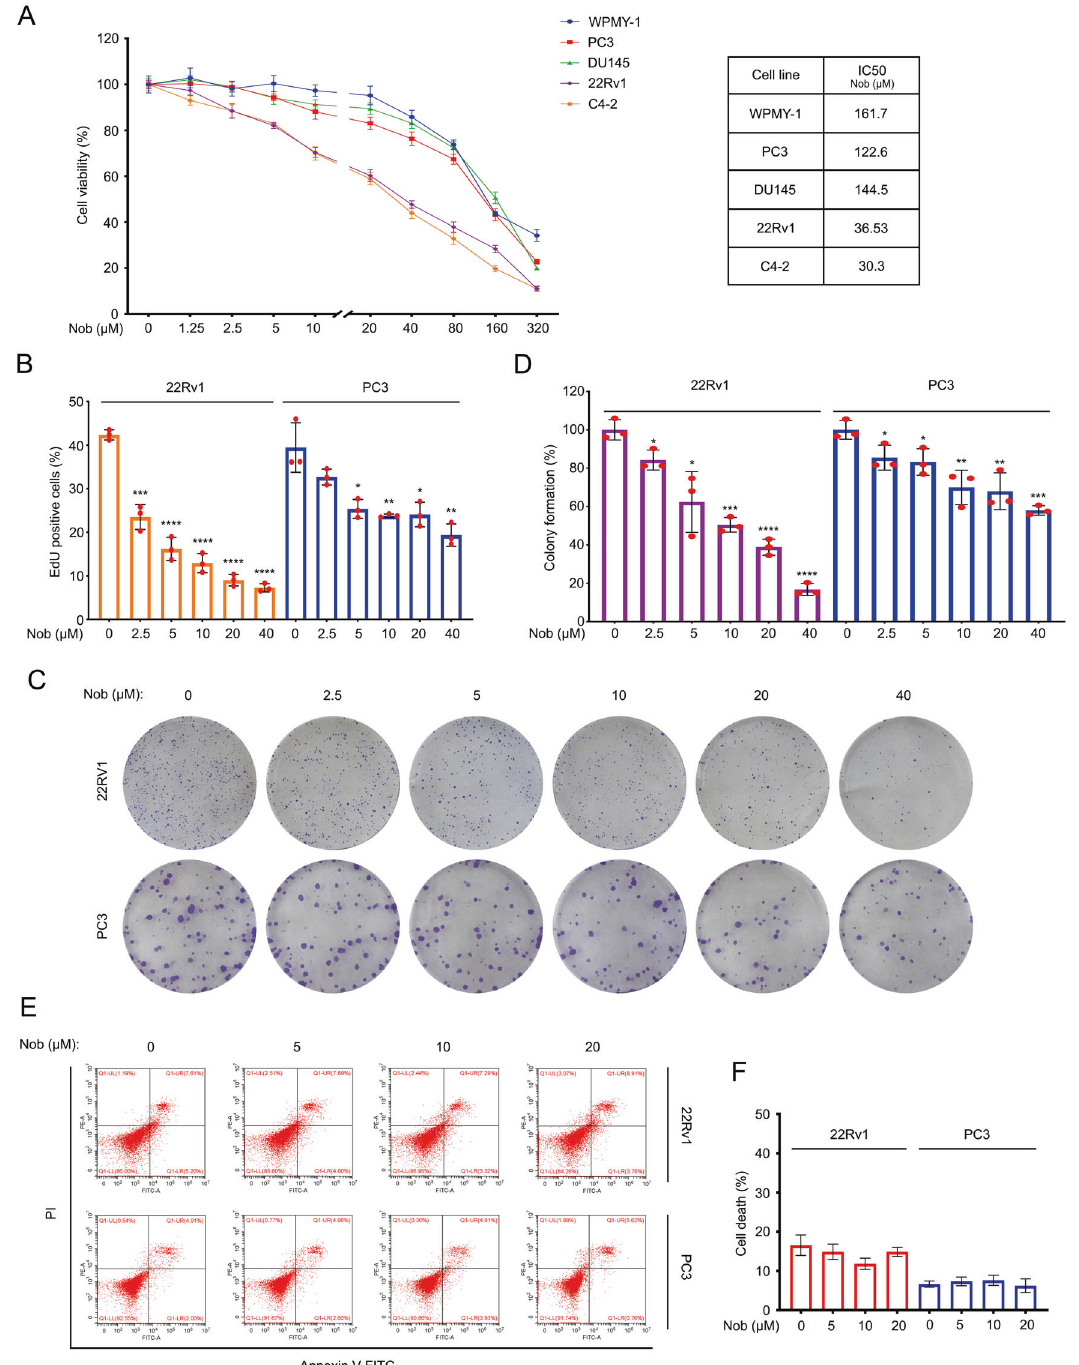
Fig. 1 Nobiletin more dramatically suppressed the proliferation of AR/AR-V7-positive prostate cancer cells. A Left: CCK8 assays of WPMY- 1, PC3, DU145, 22Rv1, and C4-2 cells exposed to nobiletin for 48 h. Mean ± SD ( n = 3), Nob nobiletin. Right: the IC50 values of nobiletin on different cells. B EdU staining assays of 22Rv1 and PC3 cells exposed to nobiletin for 24 h. Quantitative data are shown. Mean ± SD ( n = 3). C Colony formation assays of 22Rv1, and PC3 cells exposed to nobiletin for 2 weeks. D Quanti fi cation of C are shown. Mean ± SD ( n = 3). E Apoptosis analysis of 22Rv1 and PC3 cells treated with nobiletin for 24 h. F Quanti fi cation of E are shown. Mean ± SD ( n = affecting the levels of USP14 and USP22 (Fig. 4E, F). In addition, with nobiletin in the concentration gradient and time gradient as the interaction of USP22 and AR (including AR-FL and AR-Vs) was shown in the fi gure. Next, Co-IP and western blot experiments also con fi rmed. However, it is worth noting that nobiletin had no were performed to detect the interactions of AR-V7 with USP14 effect on the interactions between AR-FL and USP14/USP22, which and USP22, respectively. We were pleasantly surprised to fi nd that may explain why nobiletin has a certain selectivity in inducing the nobiletin notably prevented the interaction not only between degradation of AR-V7. USP14 and AR-V7, but also between USP22 and AR-V7, without